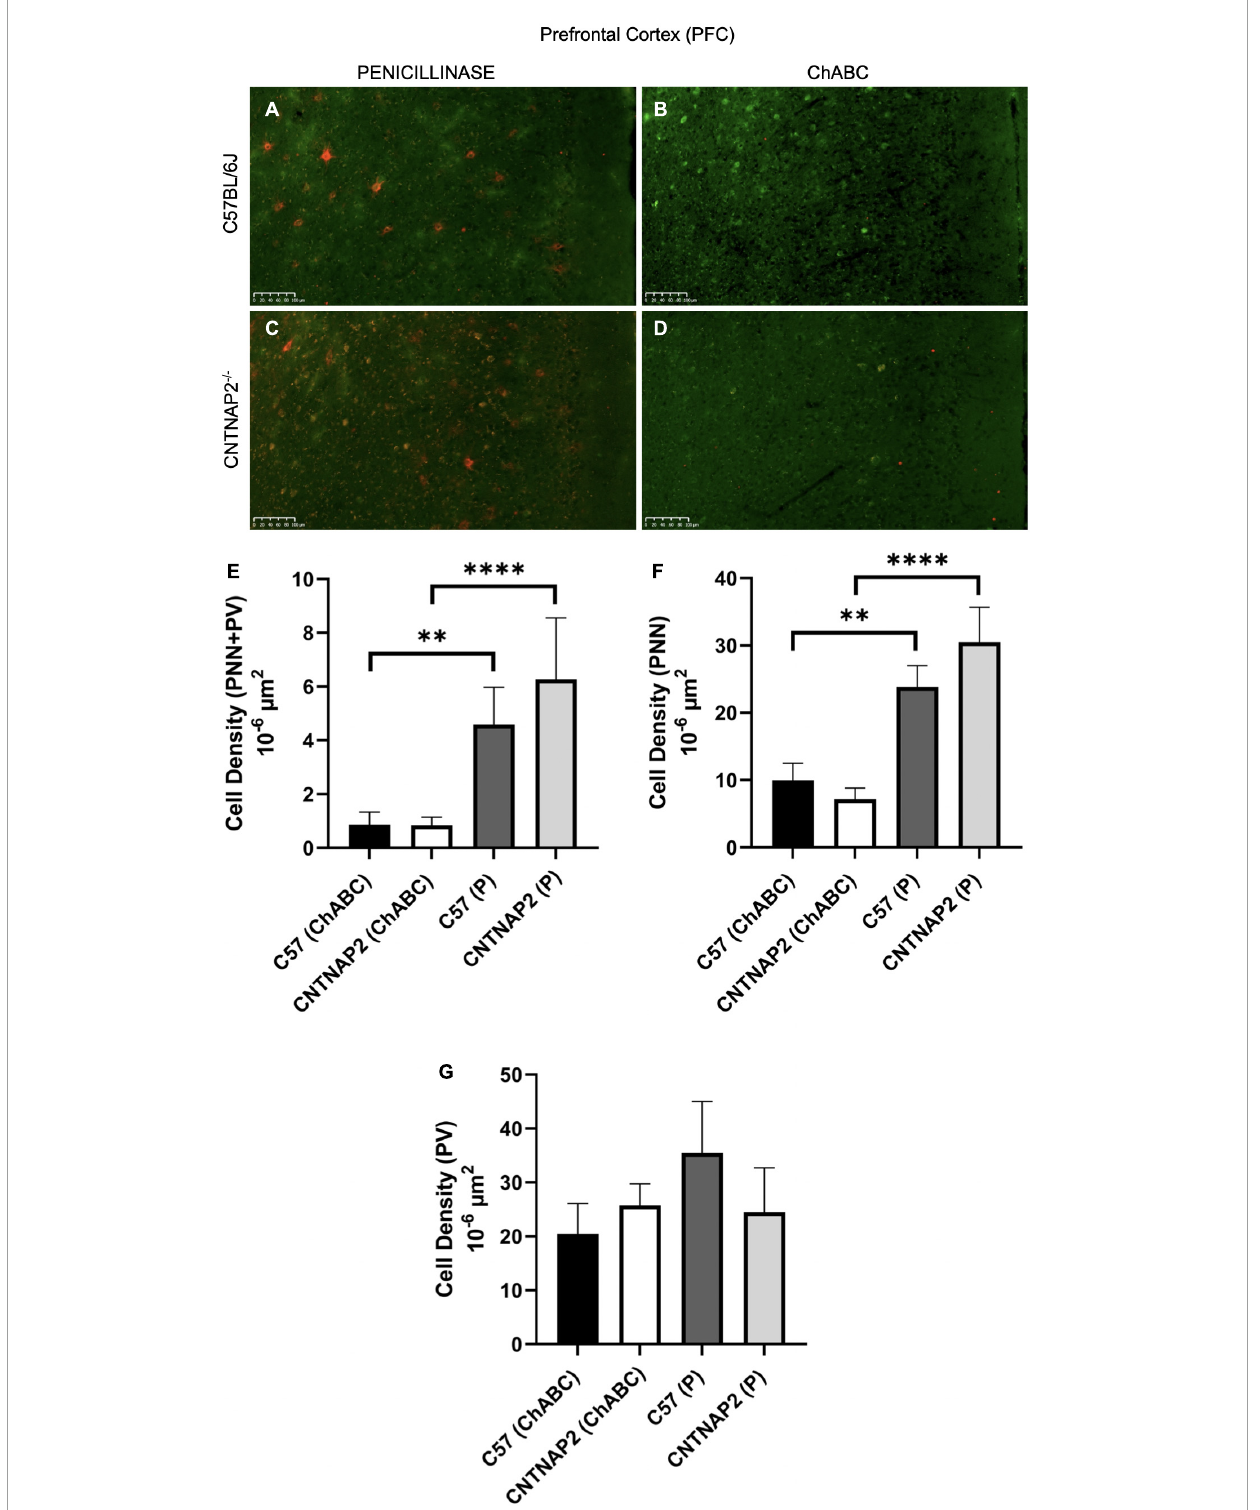
FIGURE2 Validation of perineuronal net digestion by chondroitinase ABC (ChABC) injections in the prefrontal cortex (PFC) of adult mice ( PD 60 ) after behavioral tests. (A–D) Immunofluorescence images depicting distribution of co-localized PNNs and PV-positive cells after penicillinase (left images) and ChABC (right images) injections in the PFC of adult C57BL/6J (A,B) and CNTNAP2 − / − (C,D) mice. Scale bar 100 µ m. (E–G) Quantitative estimation of PNNs co-localized with PV-positive neurons (E) , PNNs (F) , and PV-positive cells (G) in prefrontal cortex (PFC) of adult C57BL/6J and CNTNAP2 − / − mice treated with chondroitinase (C57BL/6J, n = 11; CNTNAP2 − / − , n = 13) and penicillinase (C57BL/6J, n = 10; CNTNAP2 − / − , n = 10). Data expressed as mean ± SEM ( p < 0.05). Two-way ANOVA and Fisher LSD post-hoc comparisons were performed with significant treatment effects (E: F 1 , 40 = 30.89, p < 0.0001; F: F 1 , 40 = 34.12, p < 0.0001; G: F 1 , 40 = 0.63, p = 0.4308) on panels (E,F) . Significance levels ( ∗∗ , ∗∗∗∗ ) are as noted in the